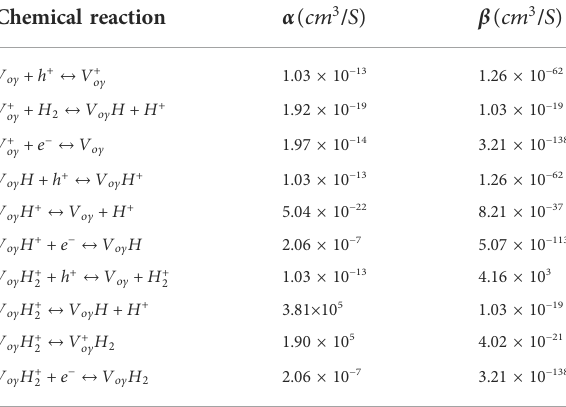
TABLE 1 Chemical reaction and rate coef fi cients (Bunson et al., 2000; Rowsey et al., 2012; Patrick et al., 2015; Sharov et al., 2022). Chemical